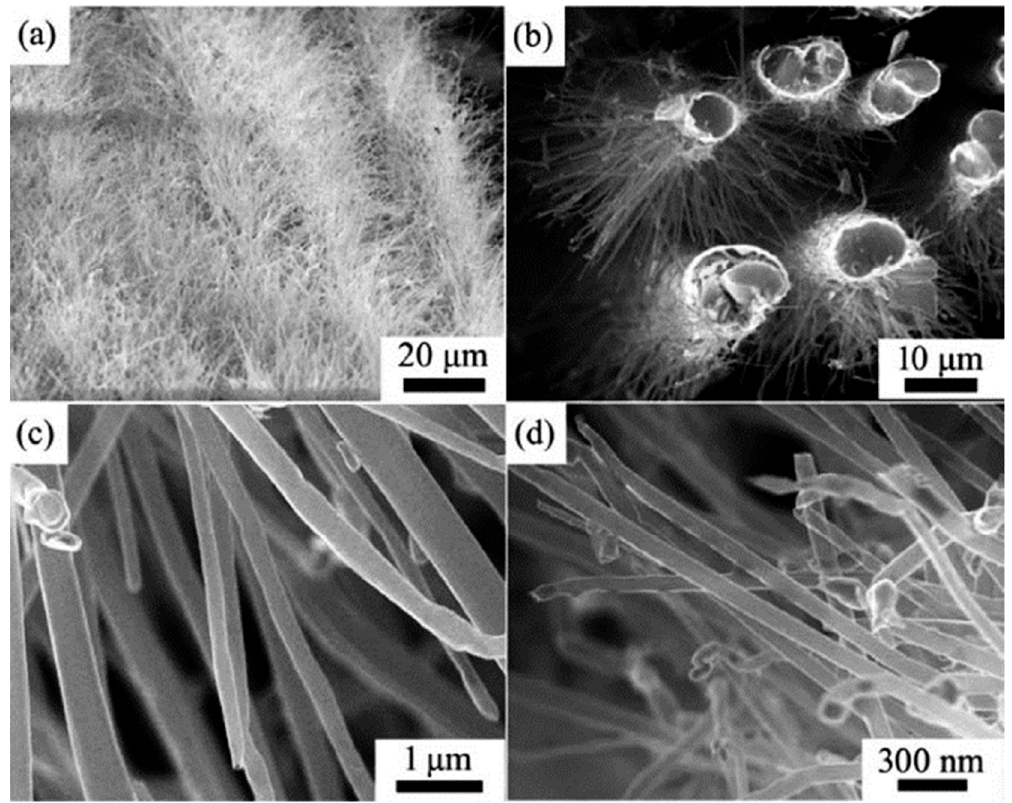
Figure 27. SEM micrographs of radially aligned CNT grown on PyC covered CF: ( a ) Top-view and ( b ) cross-section of CF, whereas ( c , d ) are magnifications of zones with CNT. Reprinted with permission from Sun, Vacuum; Ref. [45] copyright 2019, Elsevier.